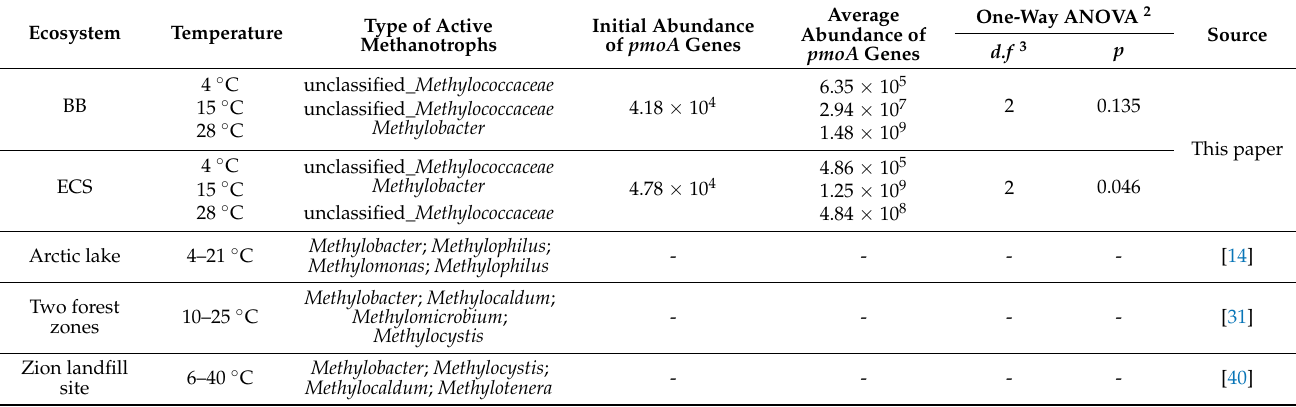
Table 3. Active methanotrophs, abundance of pmoA genes 1 (copies/g) and ANOVA of the effect of temperature on methanotrophic